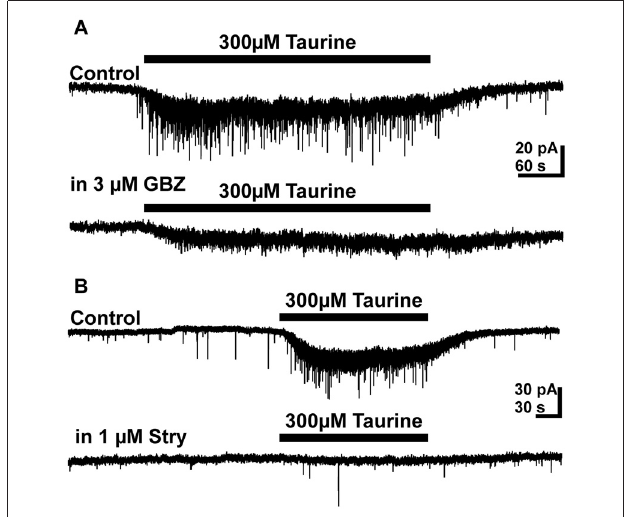
FIGURE 5 | Effect of GABA A and glycine receptor antagonists on taurine induced responses . (A) Typical current traces illustrating that 3 µ M gabazine (GBZ) abolished the taurine-induced increase in PSC frequency and reduced the amplitude of the taurine-induced inward current. (B) Typical current traces illustrating that 1 µ M strychnine abolished the taurine-induced increase in PSC frequency and reduced the amplitude of the taurine-induced inward